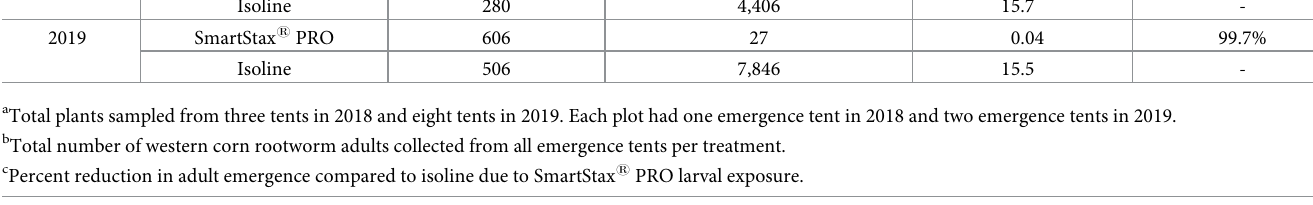
Table 1. Stand count and adult western corn rootworm emergence data for SmartStax 1 PRO and isoline field plots. Year